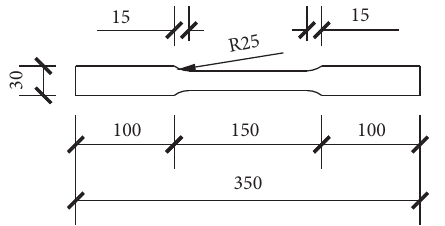
Figure 4: Design of the material specimen (units: mm).